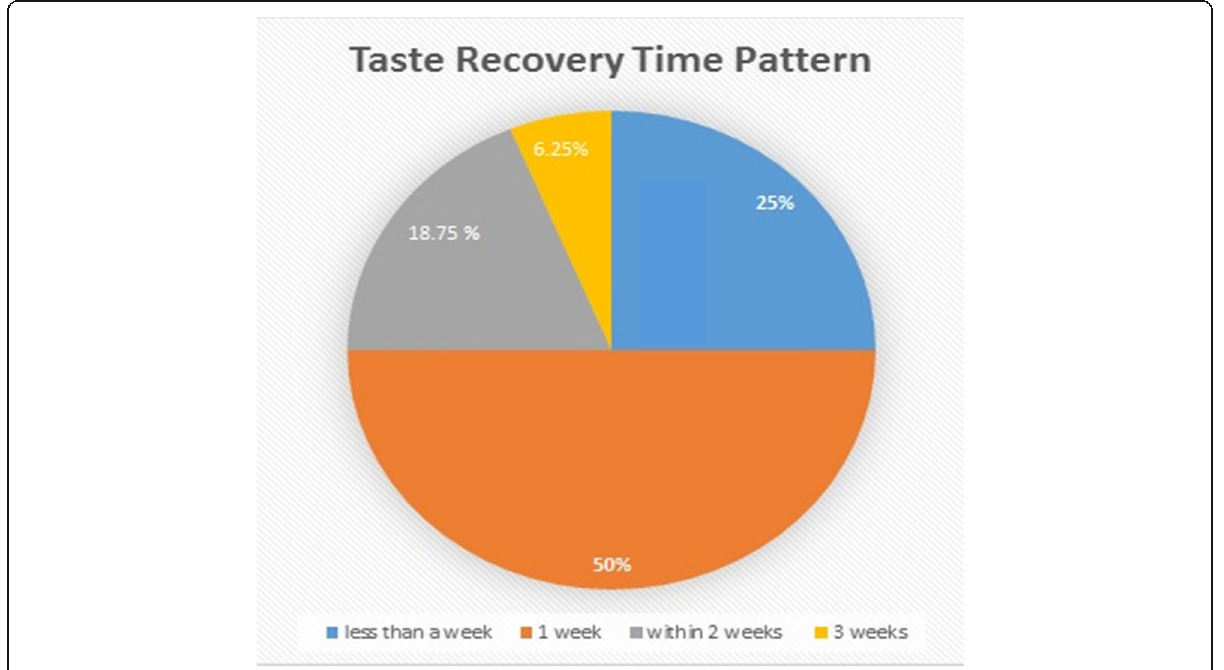
Fig. 5 The percentage of taste recovery in the corresponding